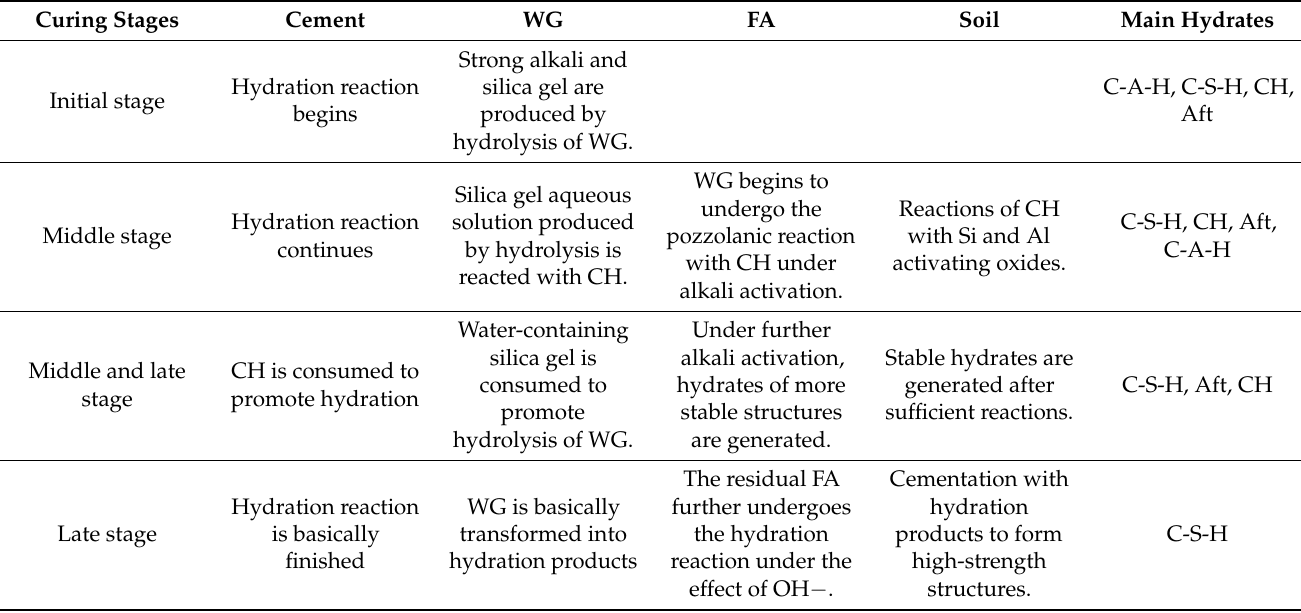
Table 8. Curing process of the composite-cemented